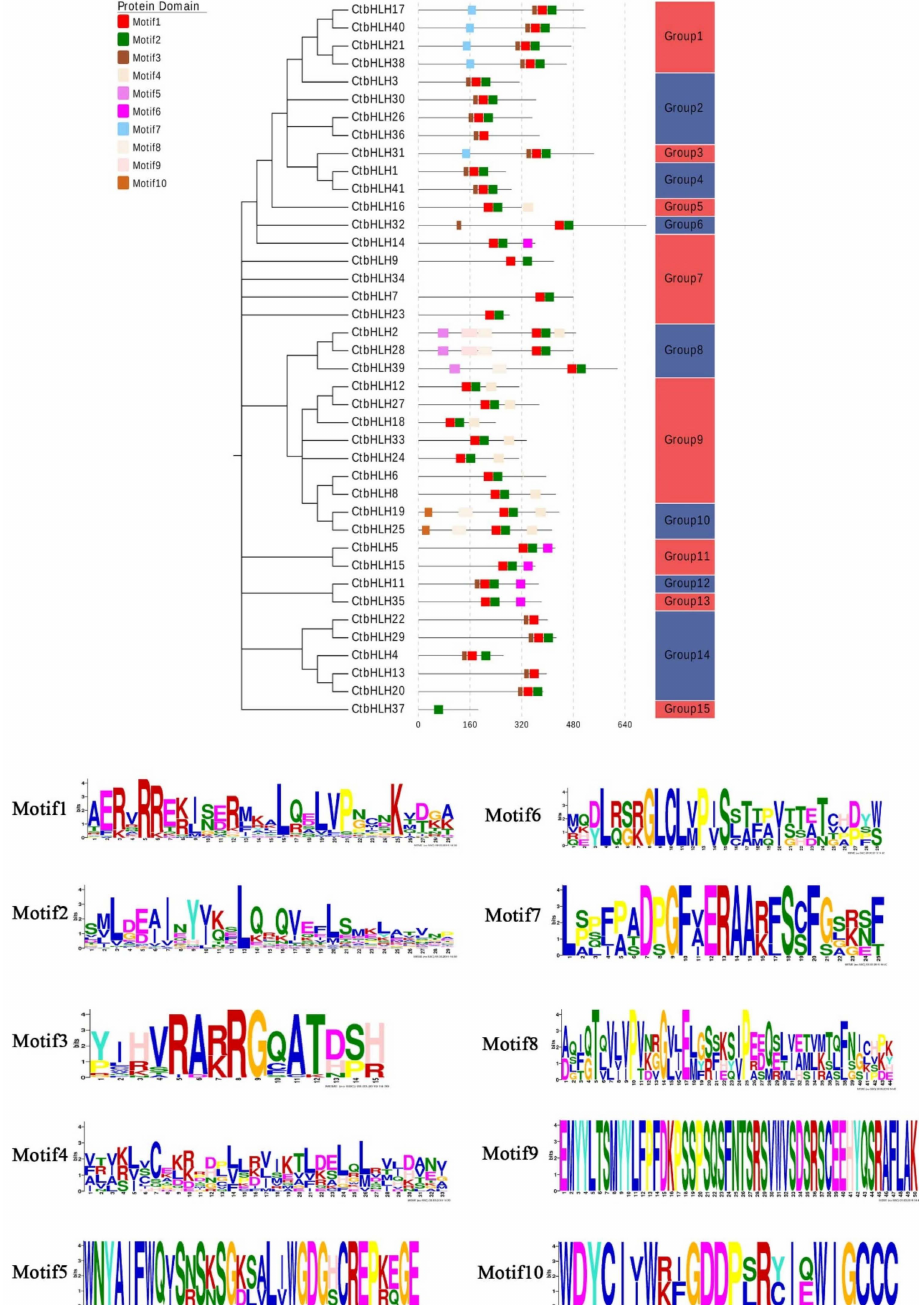
Figure 2. Motif distribution of sa ffl ower bHLH superfamily proteins. The phylogenetic tree was generated using the specific sequences of bHLH proteins obtained from Carthamus tinctorius . The online server of MEME server was used to identify the conserved motifs of Carthamus tinctorius bHLH superfamily genes. A total of 10 motifs were screened and visualized with di ff erent colors. The length of each grey line represents the relative length of the sequence. The occurrence of each block at di ff erent positions represents the location of the conserved motif to its matching